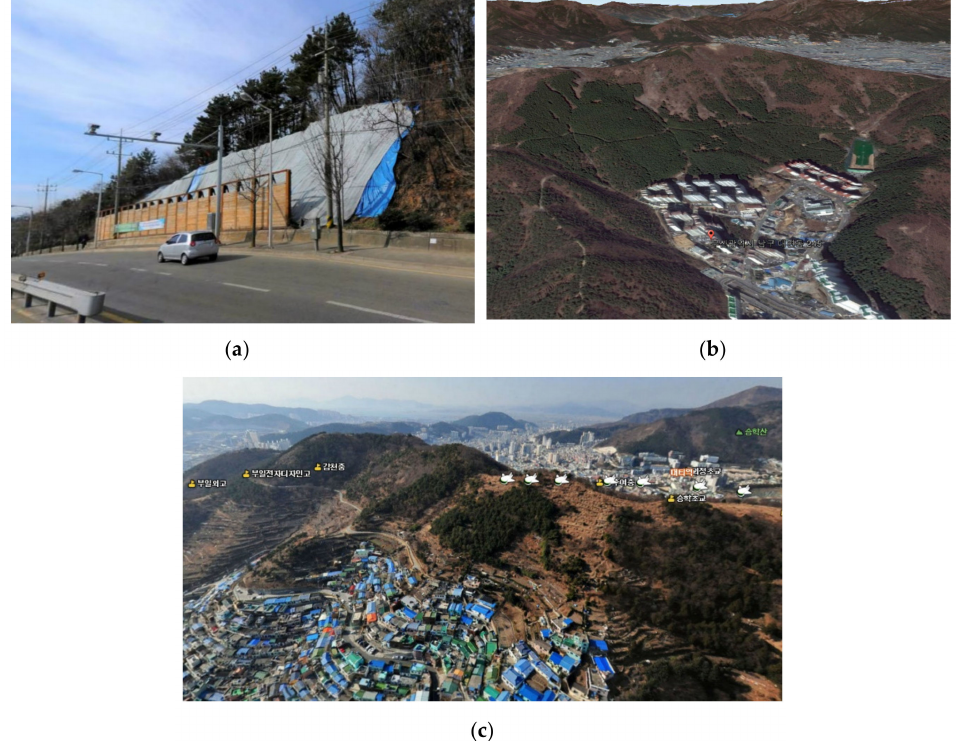
Figure 6. Map services provided by Google Earth and South Korean web portals including ( a ) street